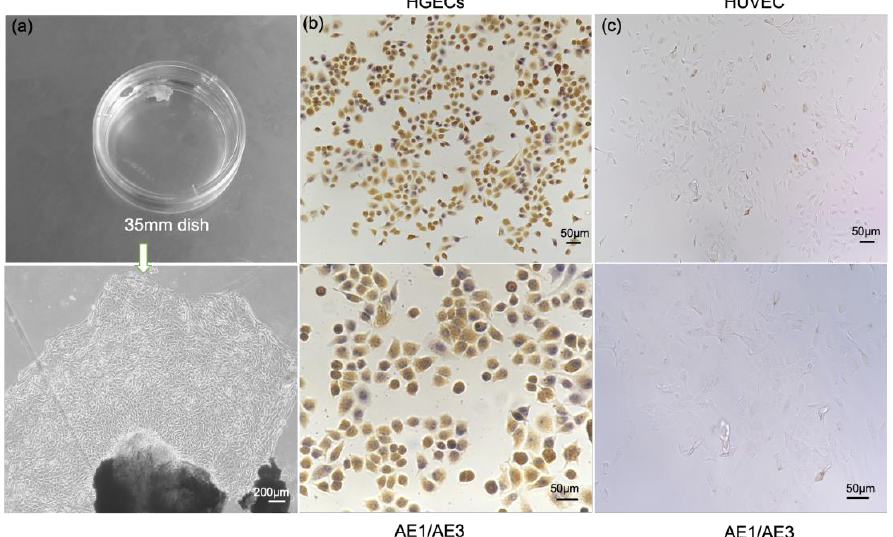
Figure 2. Primary gingival epithelial cells extraction and indirect immunocytochemical staining of cells with cytokeratin staining. ( a ) Human gingival tissue mass and the first passage HGECs showing slabstone-shaped; ( b ) HGECs immunohistochemical analysis with keratin antibody showing a positive result (the cytoplasm is brownish yellow, nuclear staining is negative, and it is blue after counterstaining with hematoxylin); ( c ) HUVEC as the control group, the expression of cytokeratin is negative.